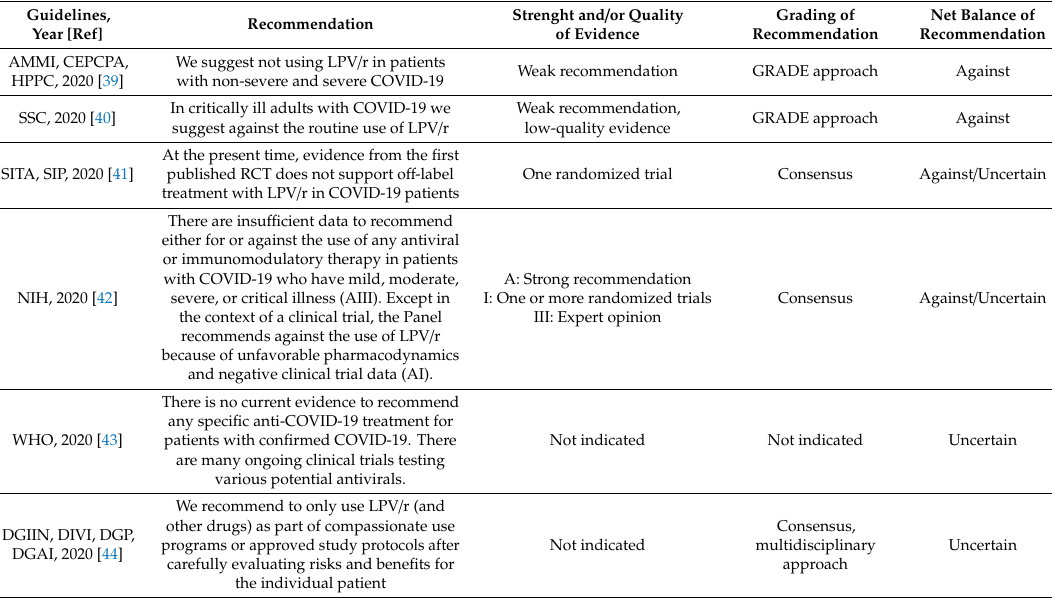
Table 1. Recommendations of the guidelines issued by international agencies and scientific societies about lopinavir / ritonavir use in